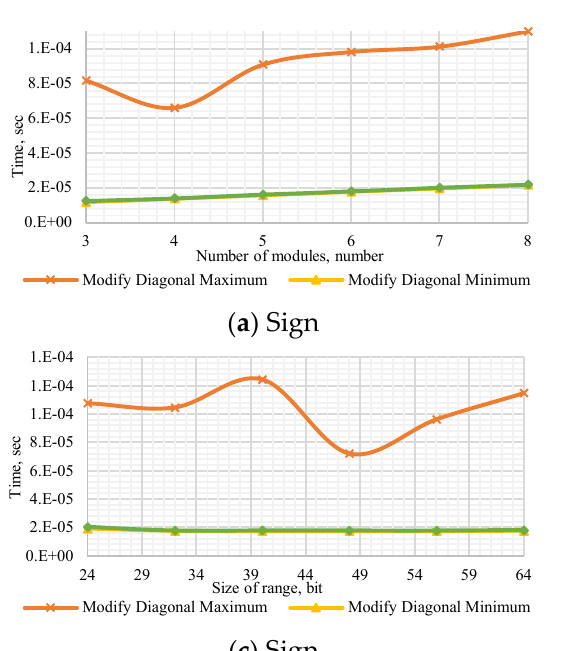
Figure A5. Performance of the Core Method to ( a ) determine the number’s sign with a dynamic number of modules p , ( b ) compare dynamic numbers of modules p , ( c ) determine the number’s sign with a dynamic bit width, and ( d ) compare numbers with dynamic bit width.